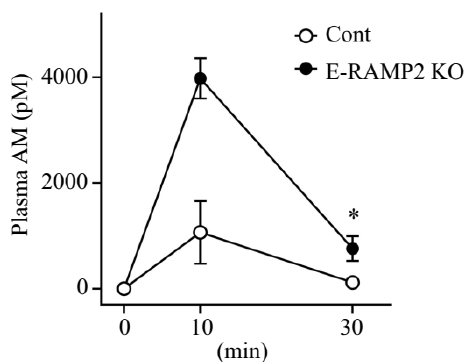
Figure 3. Plasma concentrations of human adrenomedullin administered intraperitoneally are higher in mice deficient in vascular endothelium–specific RAMP2. Changes in plasma concentration after intraperitoneal administration of human adrenomedullin in vascular endothelium–specific Ramp2-deficient mice (E-RAMP2 KO, n = 3–4) and normal controls (Cont, n = 3–4). Mann-Whitney u test, * p < 0.05 compared with Cont. Bars represent means ± SD. RAMP2, receptor activity modifying protein 2.